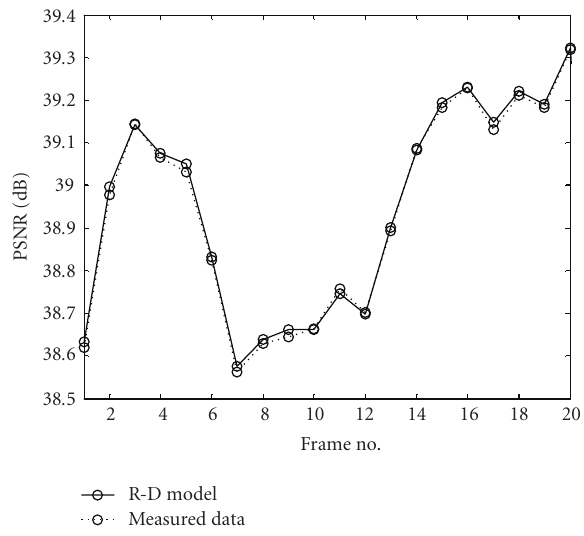
Figure 6: Comparison between the PSNR obtained using measured data and the R-D